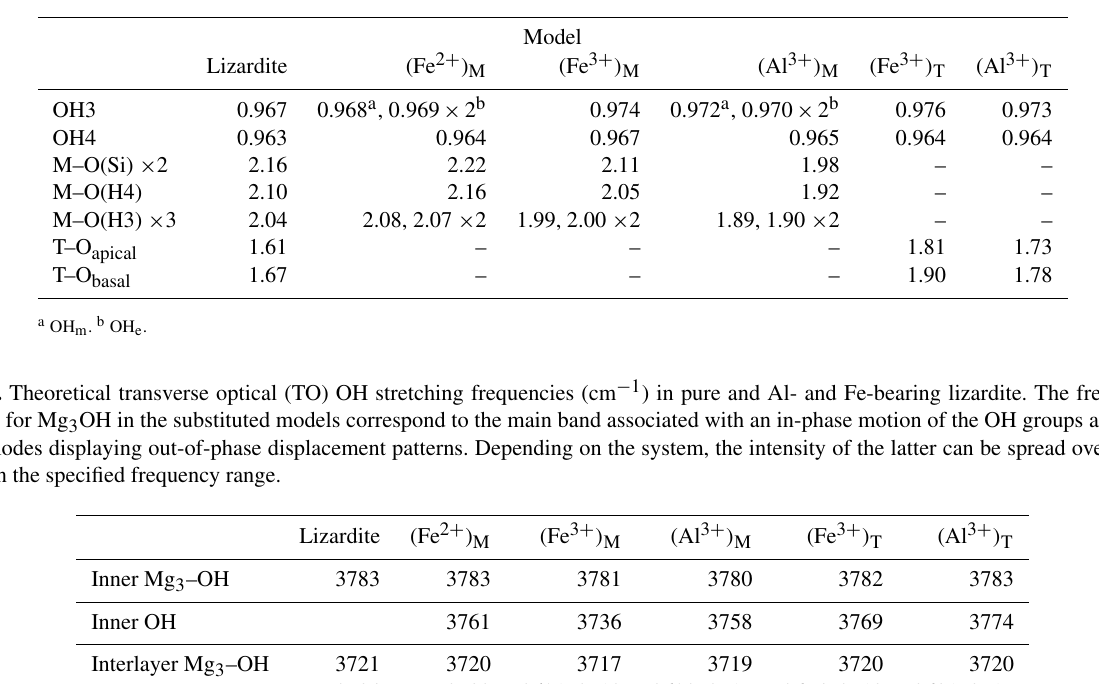
Table 1. Selected theoretical bond lengths (Å) in pure and Fe- and Al-bearing lizardite. The interlayer and inner OH correspond to OH3 and OH4, respectively.